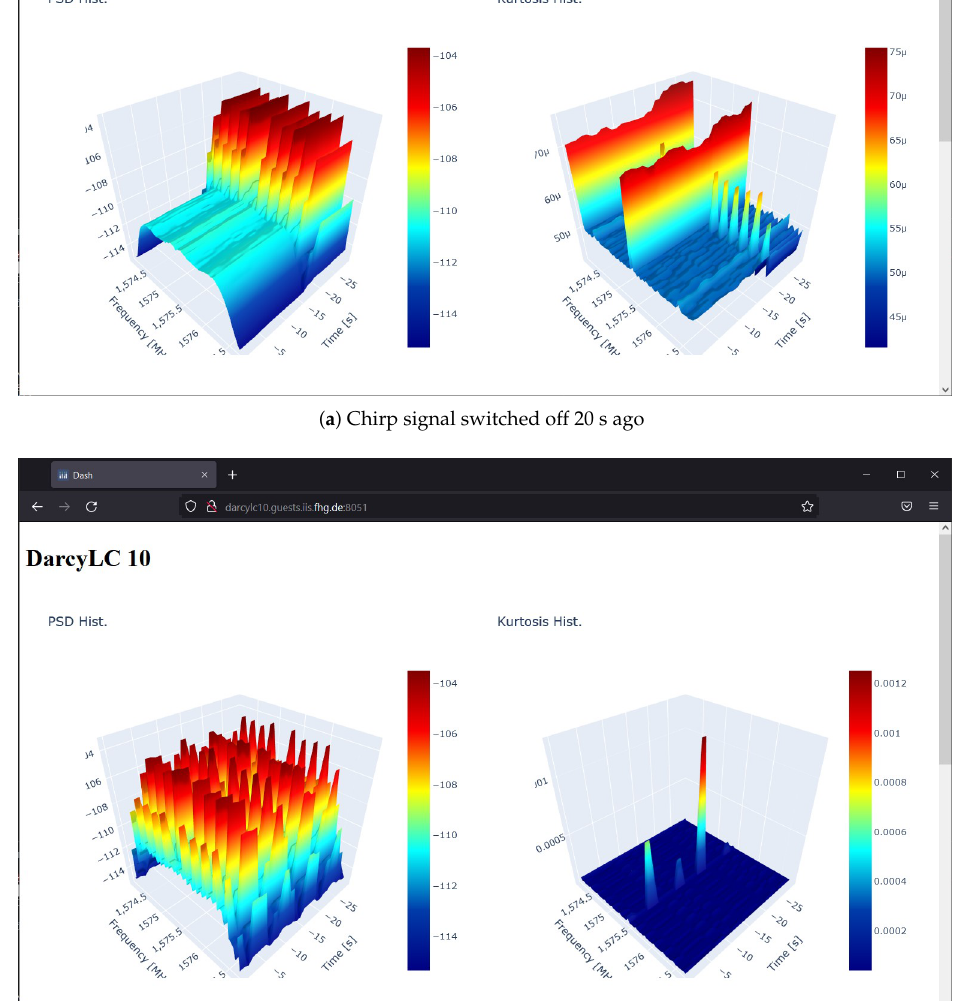
Figure 8. Screenshot of the web server front end, with interference visualizations of the spectral power and spectral kurtosis. The real-time measurements are done in a controlled